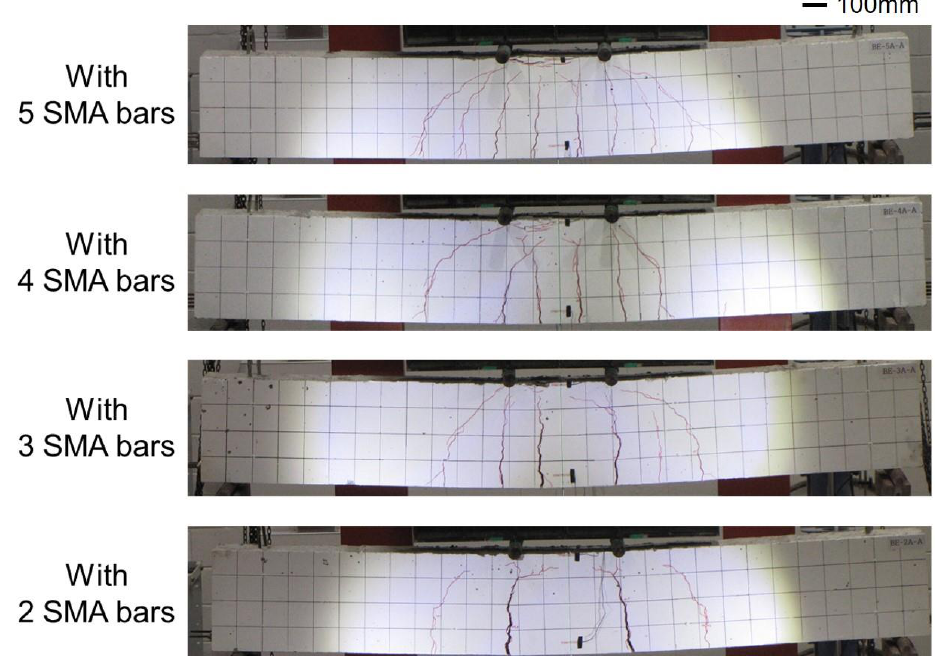
Figure 16. Experimentally observed crack patterns of RC beams after bending fracture with deflection of 40 mm, with various numbers of activated Fe-SMA bars of 5, 4, 3 and 2 [31].